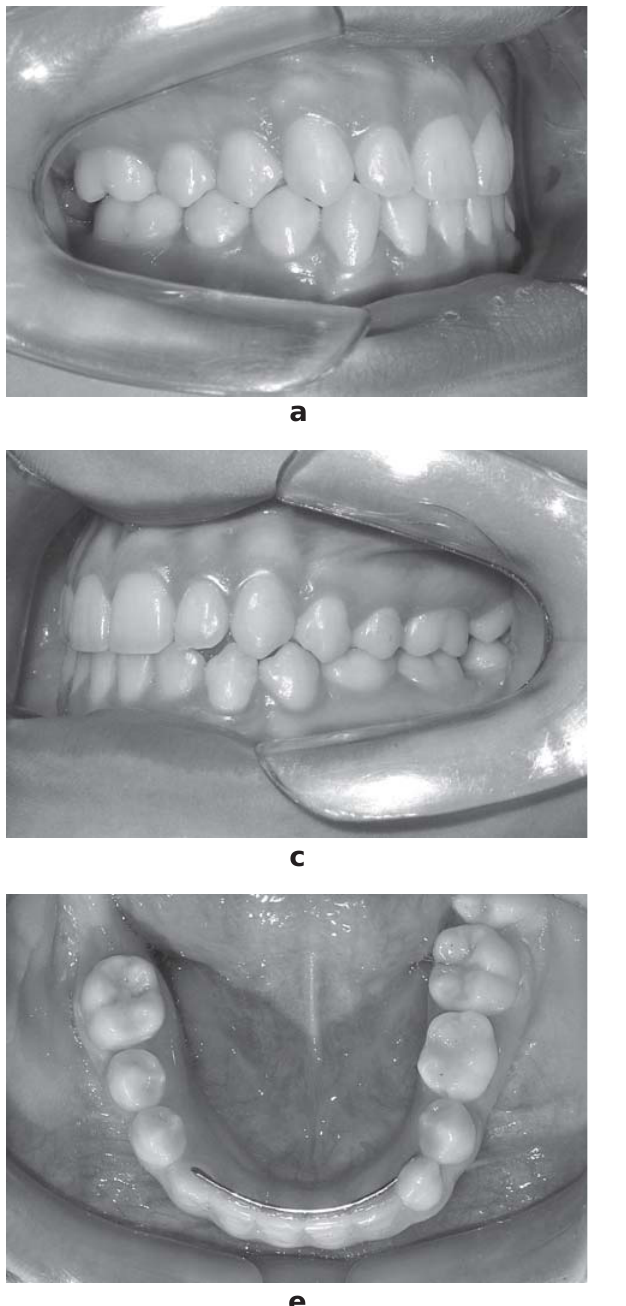
FIGURE 2- (a-f) Final intraoral photographs and panoramic